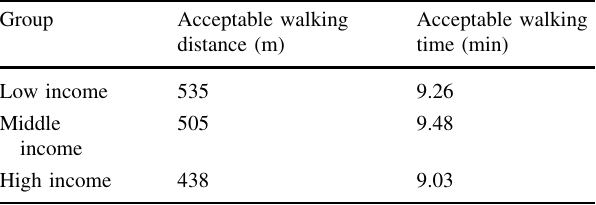
Table 2 Acceptable walking distance and time to transit station of TOD residents in each income group